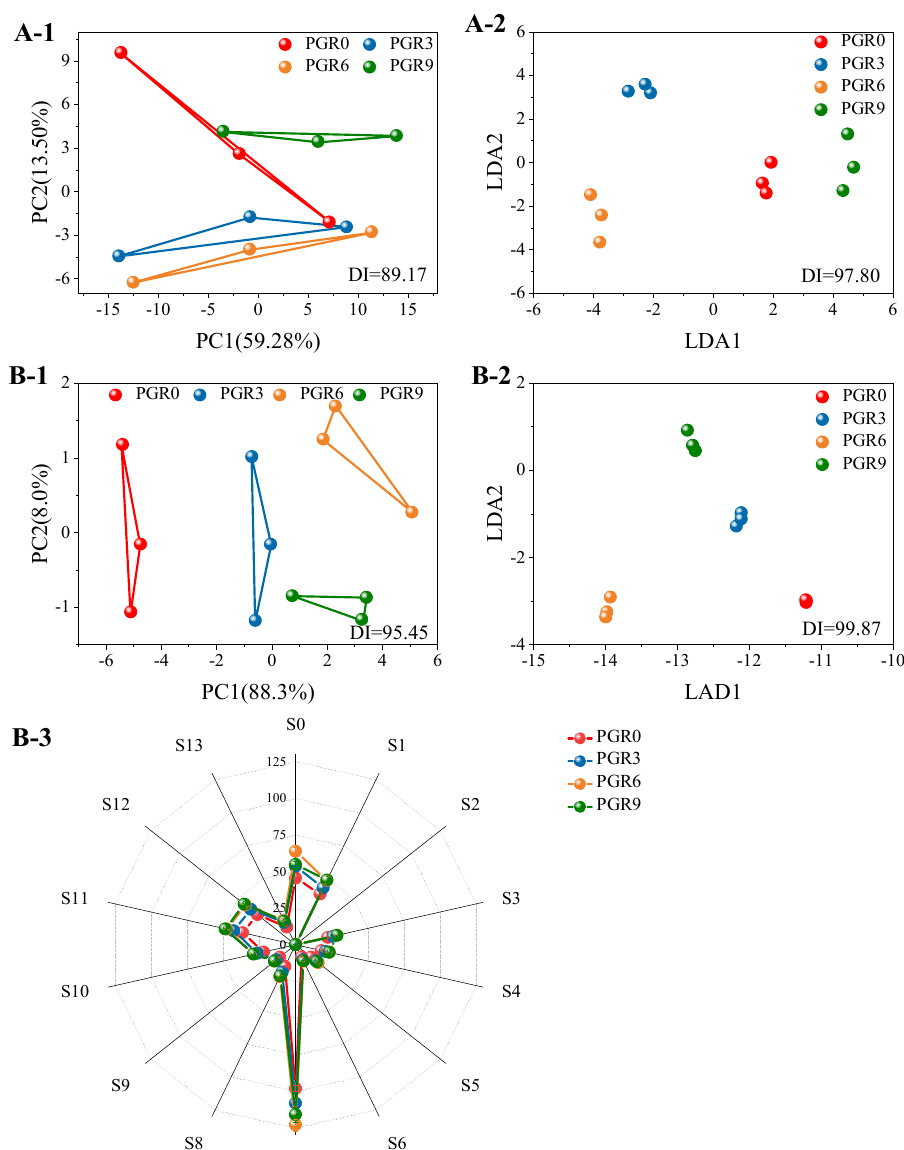
Figure 3. Electronic tongue and electronic nose results of wheat bread enriched with different addi- tion amounts of PGR flour. ( A − 1 , A − 2 ): PCA and DFA analysis of electronic tongue. ( B − 1 – B − 3 ): PCA, DFA analysis, and spider plot of an electronic nose. PGR0: without PGR flour; PGR3: with 3 g/100 g PGR flour; PGR6: with 6 g/100 g PGR flour; PGR9: with 9 g/100 g PGR flour.